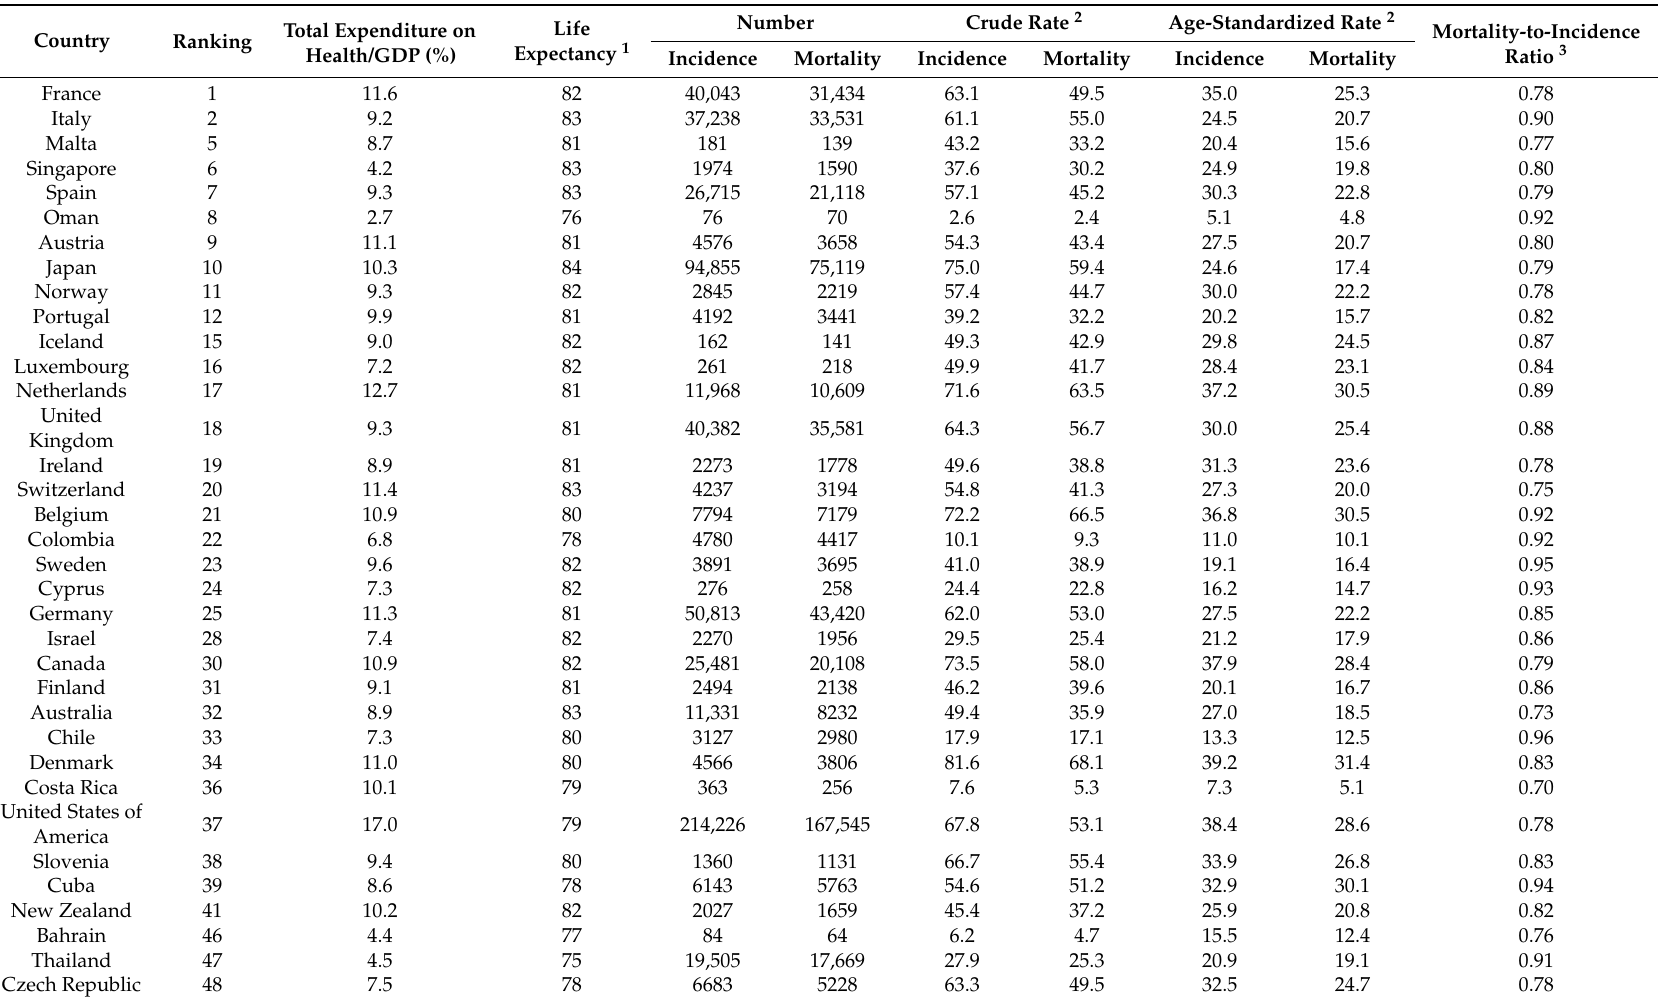
Table 2. Summary of World Health Organization rankings, total expenditure on health/GDP, life expectancy, lung cancer incidence, mortality, and mortality-to-incidence ratio of selected